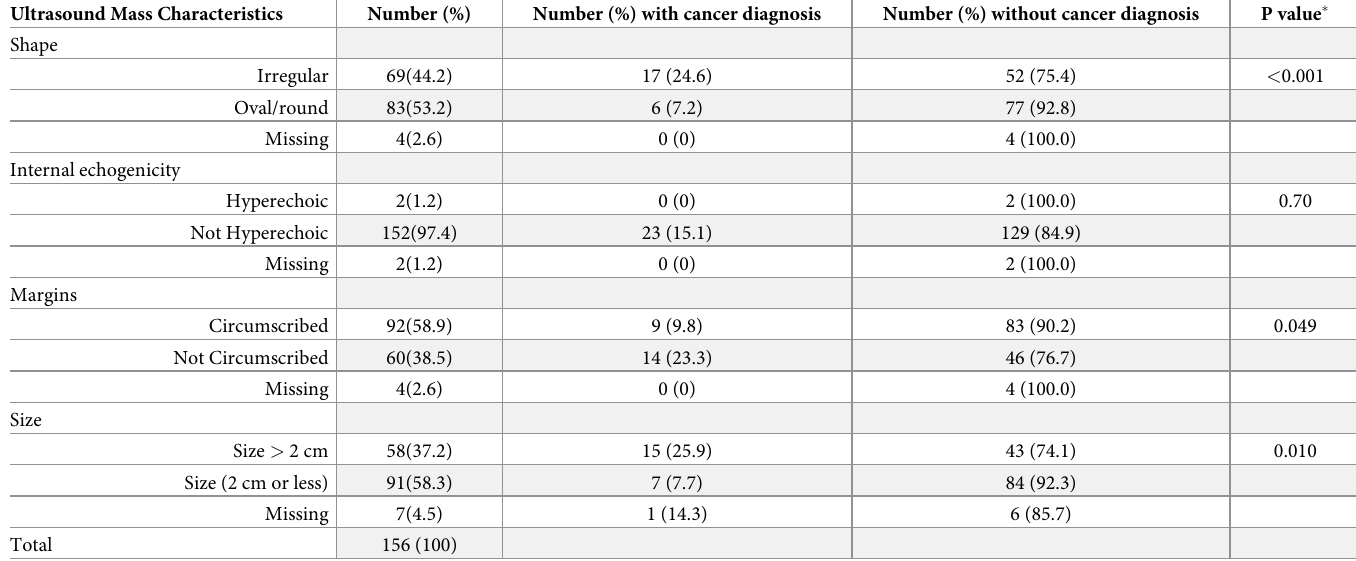
Table 1. Characteristics used to describe masses on ultrasound (N = 156).